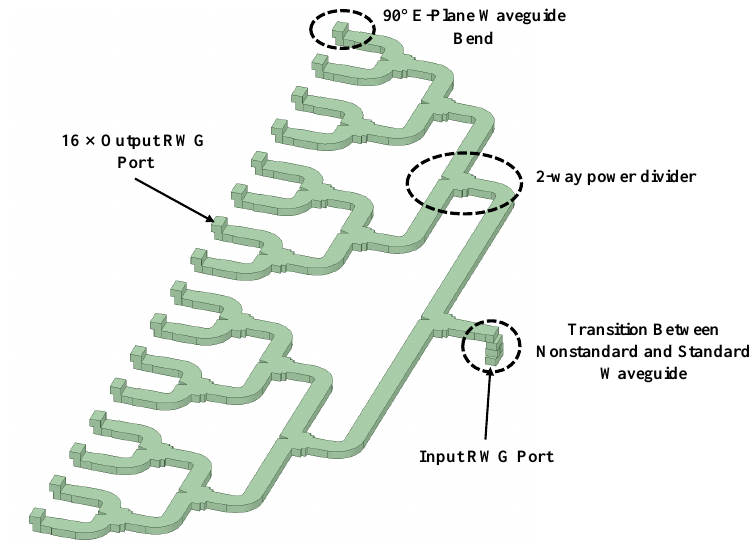
Figure 6. The complete 16-way power divider design.